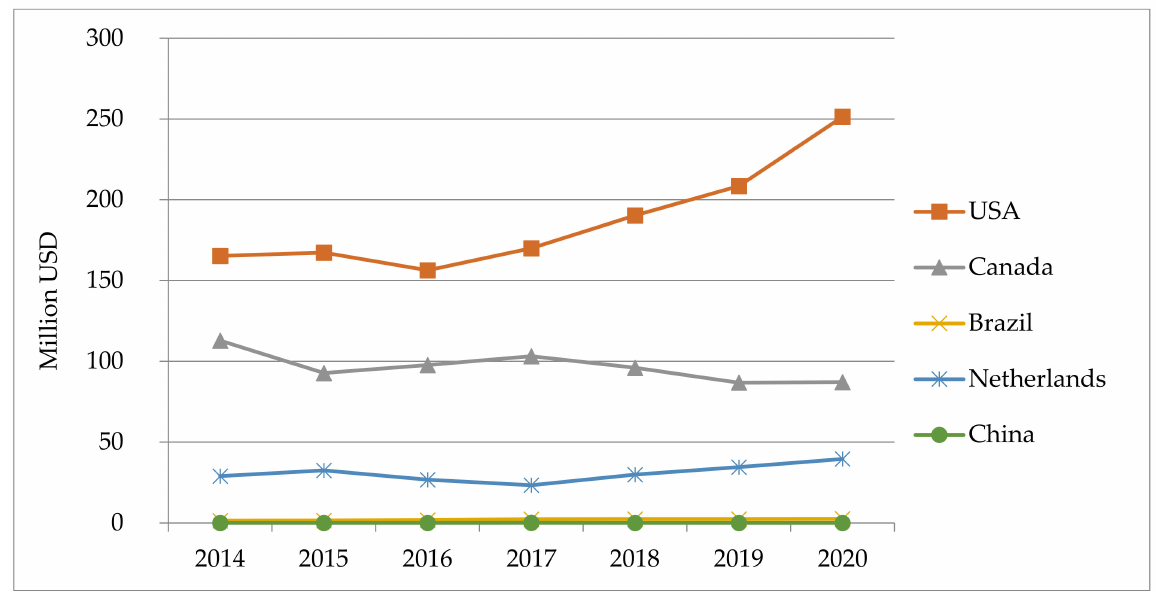
Figure 6. Value of exported bovine semen in selected countries in the period 2014–2020, in